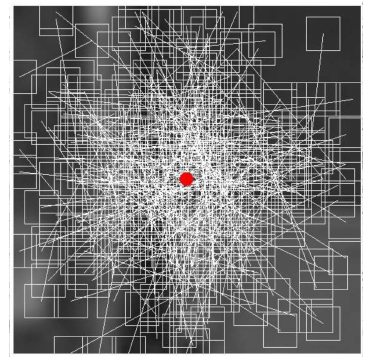
Figure 2. 256 patch-pairs of BRIEF